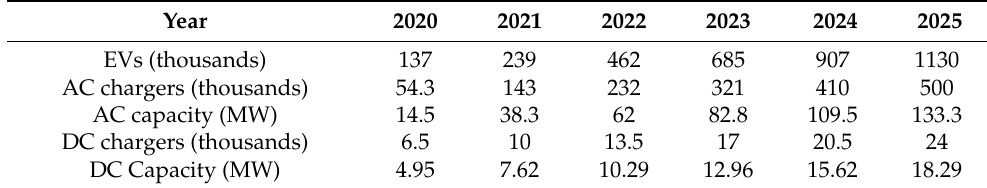
Table 2. The estimated EV and EV charger parameters.